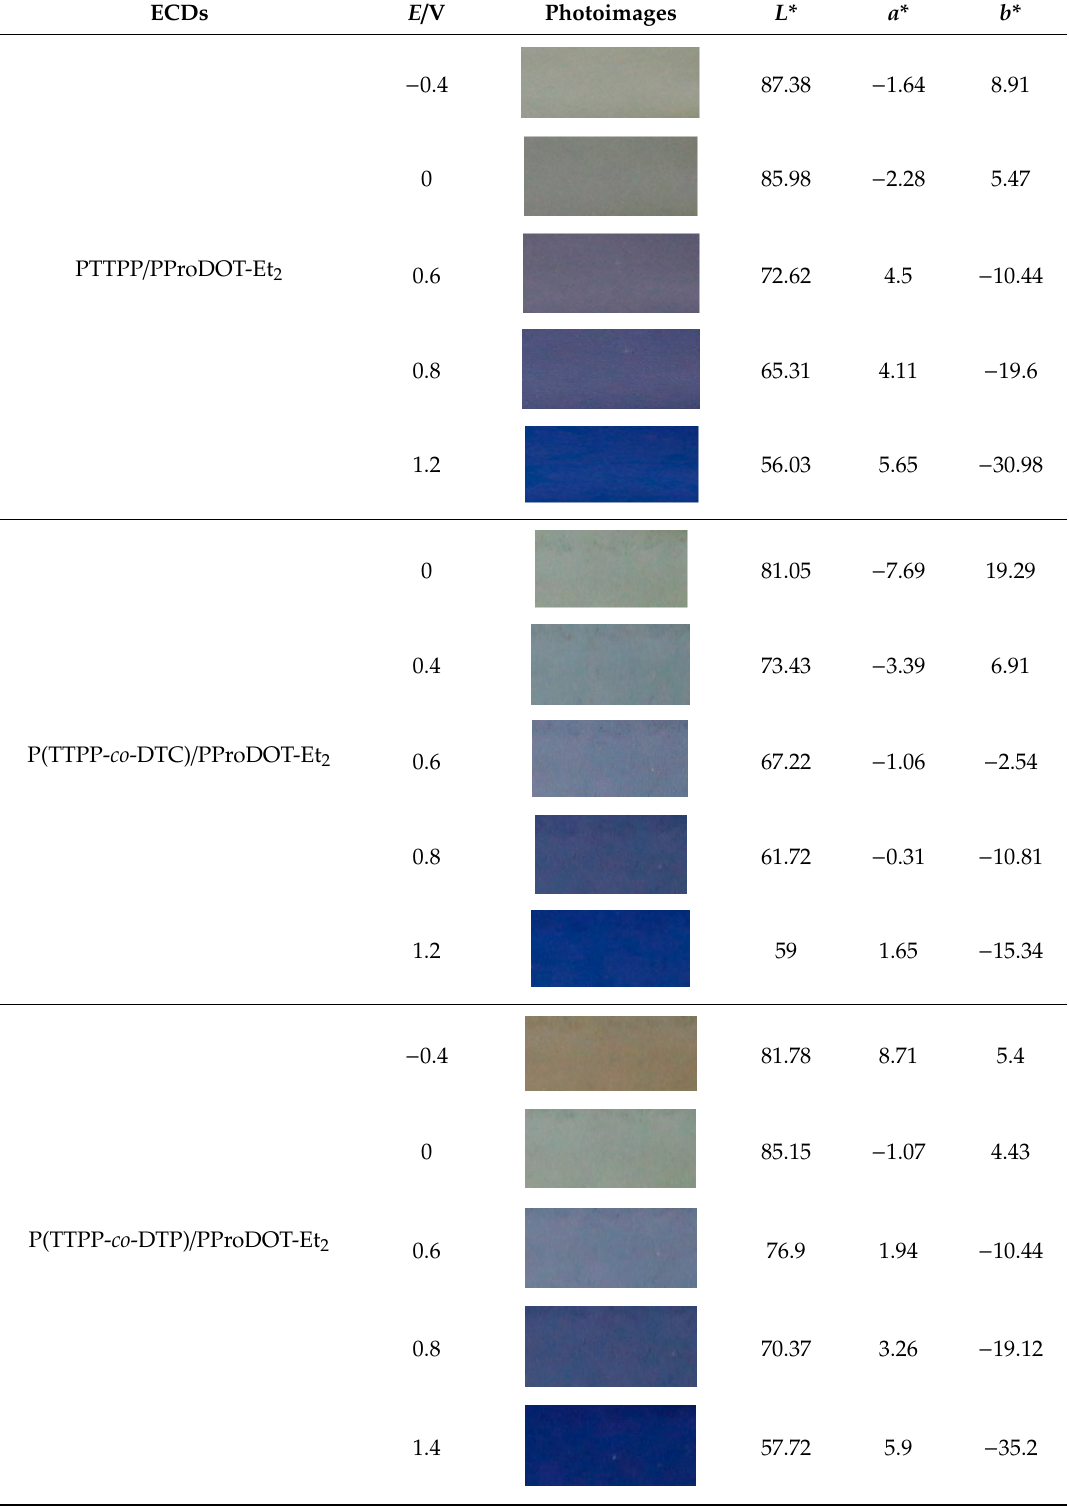
Table 4. Photoimages and L *, a *, and b * values of ECDs.